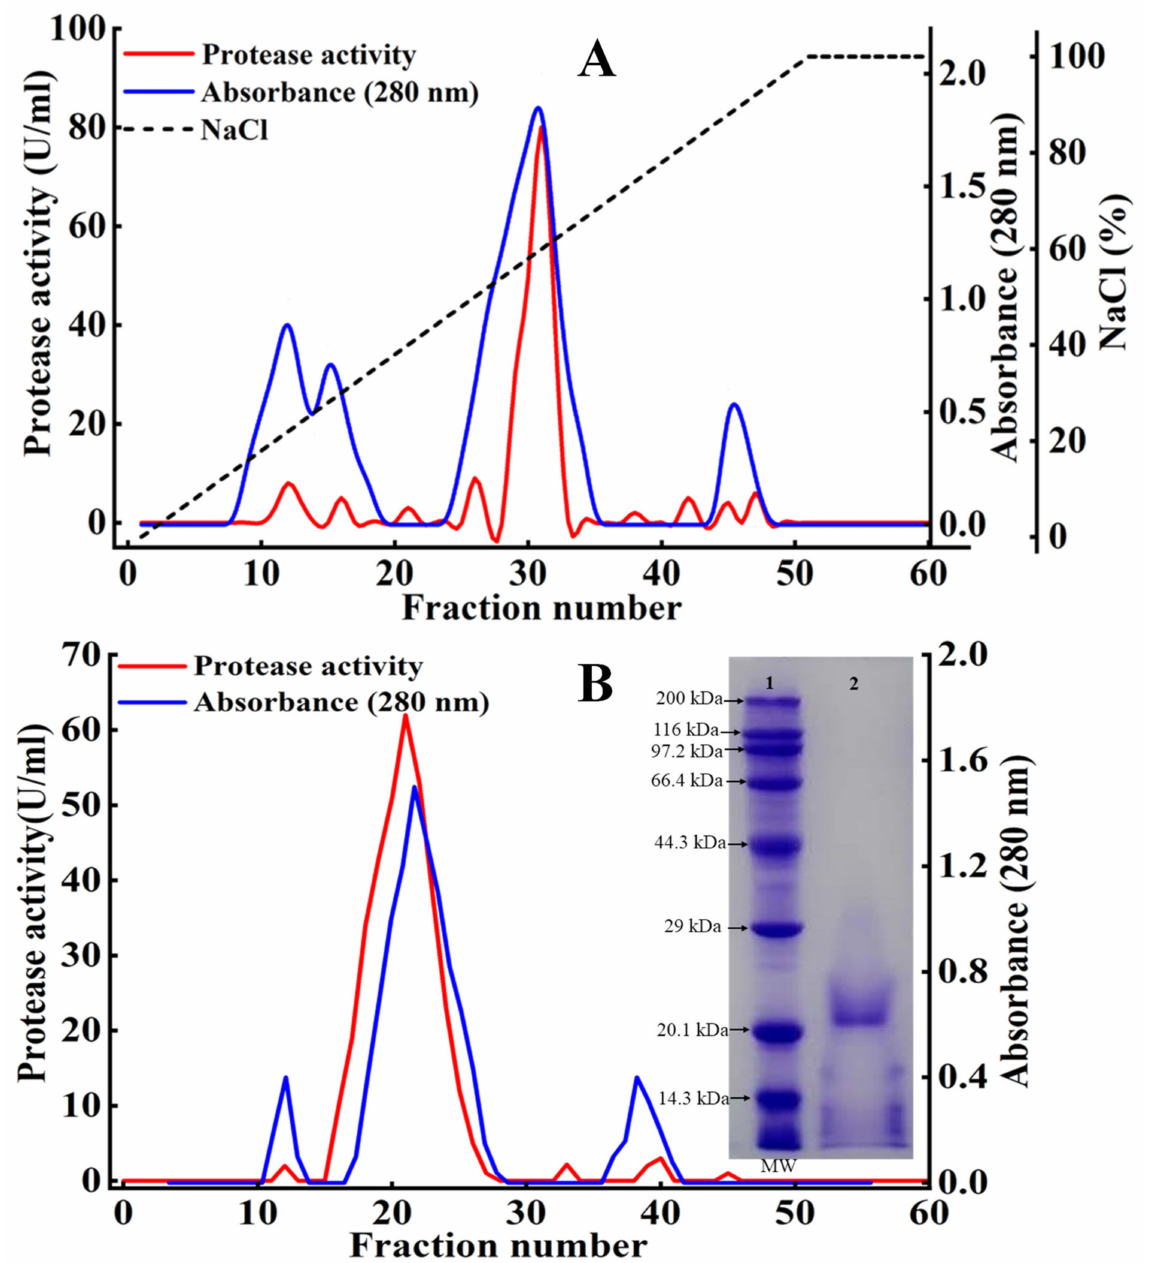
Figure 2. The S. xylosus A2 protease purification by cation exchange chromatography ( A ) and gel- filtration chromatography ( B ) and SDS-PAGE analysis of the sample from gel filtration. Lane 1, protein molecular weight marker; lane 2, the sample after gel-filtration chromatography